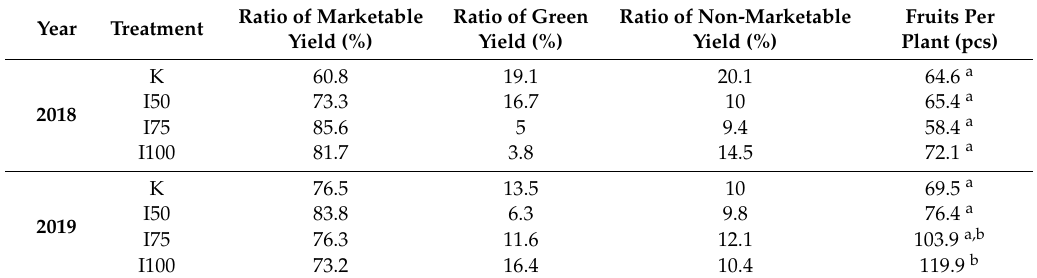
Di ff erent letters indicate statistically significant di ff erences at p < 0.05 level regarding the di ff erent years. Table 5. The ratio of marketable, green, and non-marketable fruit